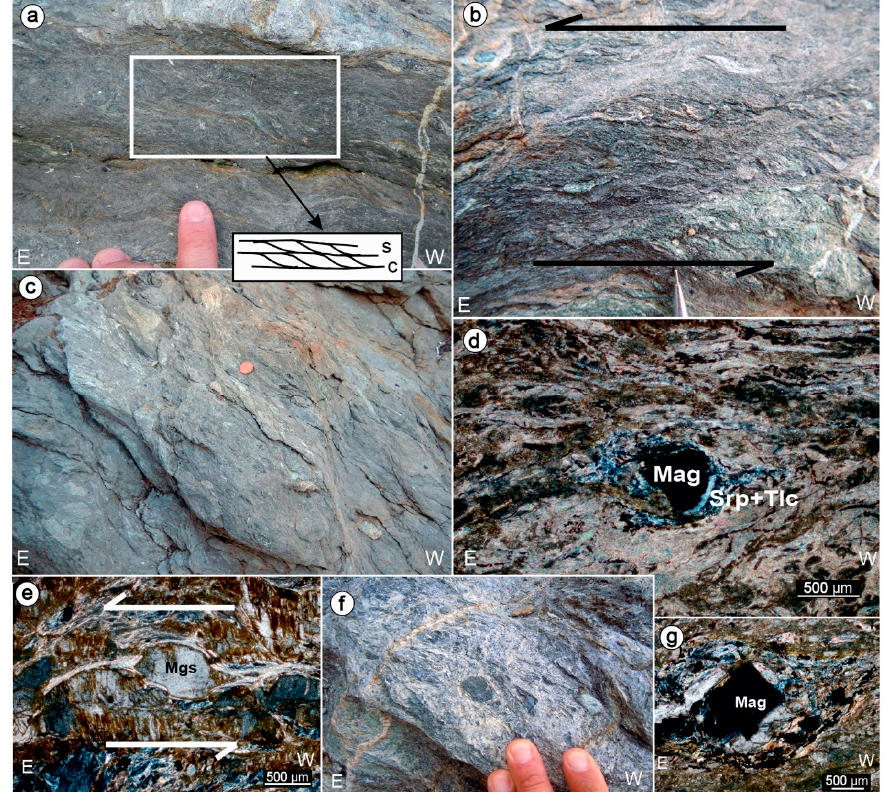
Figure 8. Ultramyloniticserpentinite domain. ( a , b ) closely spaced top-to-the-east S/C and shear bands structures, respectively; ( c ) highly foliated matrix with tiny porphyroclasts aligned along the main schistosity; ( d ) Crossed polars micrograph showing an asymmetric magnetite porphyroclast with well evident strain shadow, mainly composed of talc and serpentine and pointing to a top-to-the-east shear sense; ( e ) crossed polars micrograph showing an asymmetric (top-to-the-east shear sense) magnesiteporphyroclast with a well evident strain shadow, mainly composed of talc; ( f ) rounded ultramafic porphyroclasts dispersed in a highly foliated matrix; ( g ) crossed polars micrograph showing an euhedral magnetite porphyroclast with a well-developed strain shadow, mainly composed of talc and serpentine.